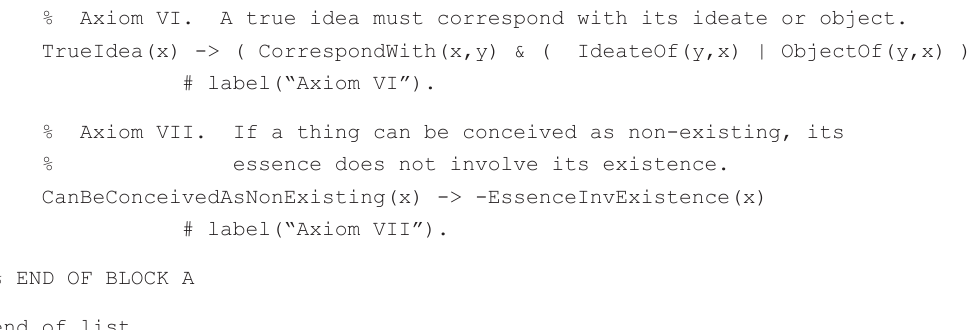
Figure 1: A mace4 script for the DAPI. A percent (%) mark at the beginning of a line delimits a comment. For the purpose